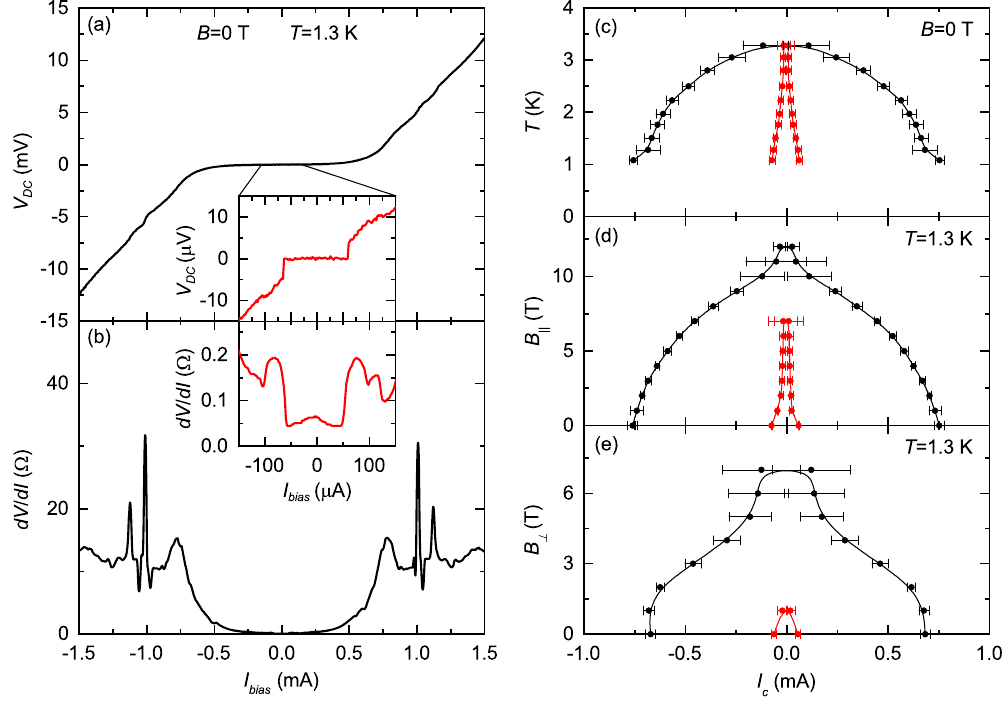
Figure 4. ( a ) IV curve of sample 4 measured at T = 1.3 K and B = 0 T. Inset: expanded view on the low-current region where the transition due to the surface can be seen. ( b ) Differential resistance measured simultaneously with the IV curve. Inset: differential resistance corresponding to the inset of ( a ). ( c – e ) Critical currents of the superconducting volume (black) and surface (red) as a function of ( c ) the temperature, ( d ) parallel magnetic field and ( e ) perpendicular magnetic